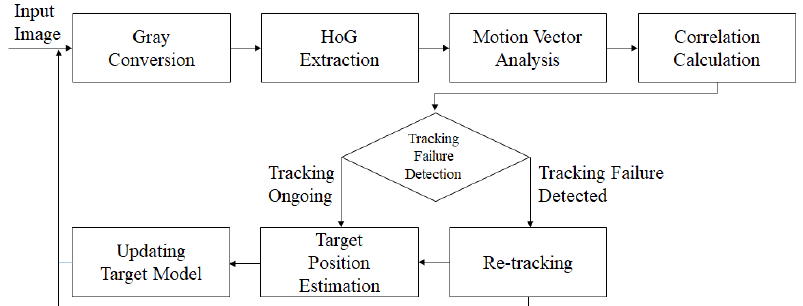
Figure 1. Block diagram of the proposed method.